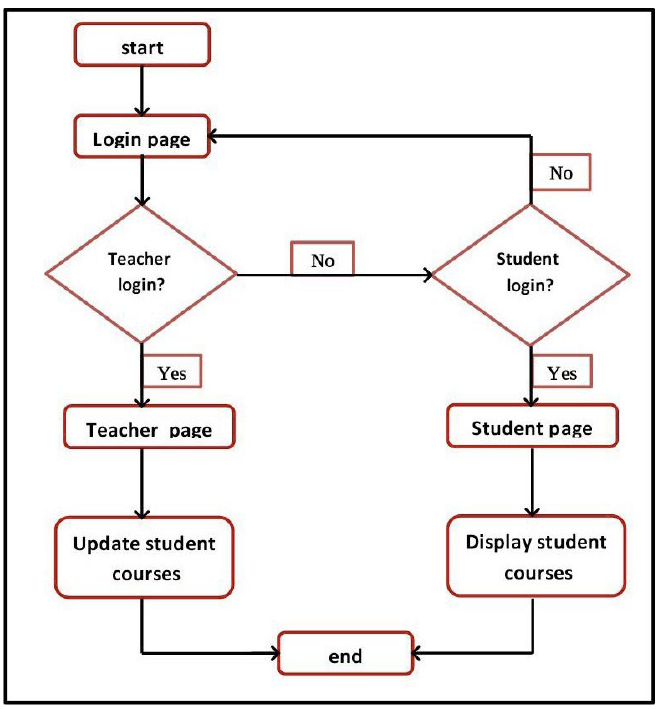
Fig. 8. The flowchart of how the proposed platform would work